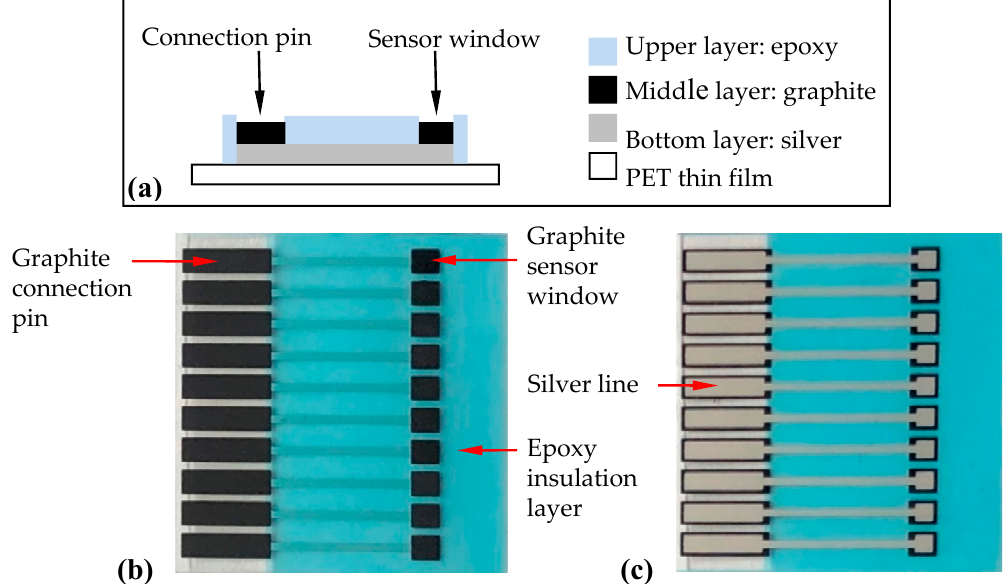
Figure 1. Fabrication of the screen-printed carbon electrode (SPCE) by screen printing. ( a ) Schematic side-view diagram of the SPCE, ( b ) a top-view photo of the SPCE, and ( c ) a bottom-view photo of the SPCE. The substrate was 28 mm × 28 mm while the sensor window’s area was 2 mm × 2 mm.